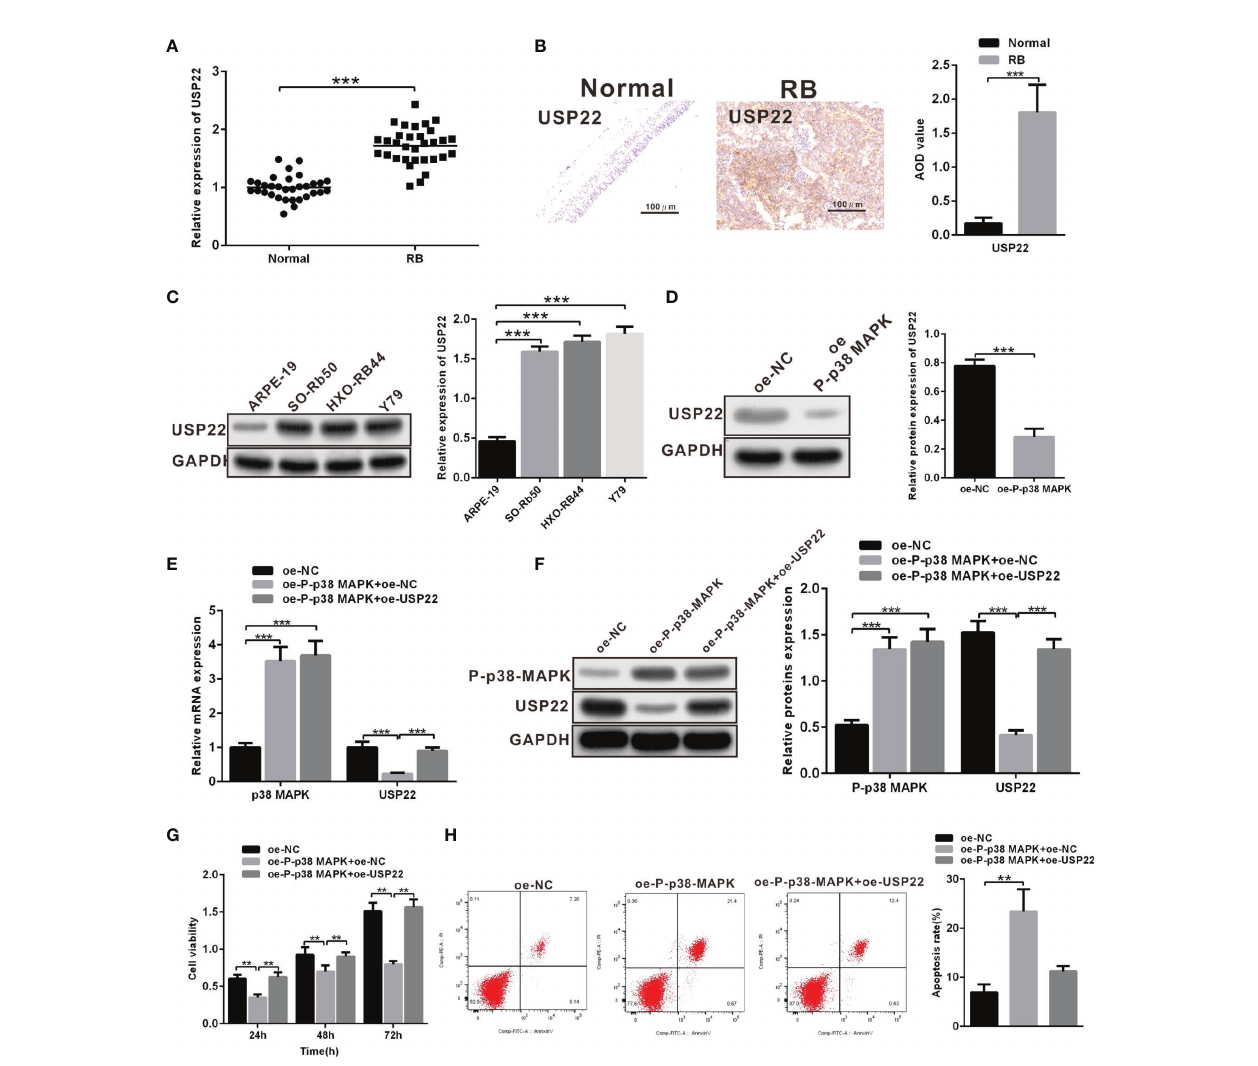
FIGURE 3 | Overexpression of USP22 reverses the inhibitory roles of P-p38 MAPK on RB cell functions. (A) USP22 expression in clinical samples was detected using RT-qPCR (n = 32). (B) USP22 expression in clinical samples was detected using IHC assay. (C) USP22 expression in RB cell lines was measured using western blot analysis. (D) USP22 expression in Y79 cells that over expressed P-p38 MAPK was detected by western blot analysis. (E, F) The expression of P-p38 MAPK and USP22 after overexpression of P-p38 MAPK and USP22 was respectively determined by the means of RT-qPCR and western blot analysis. (G) Cell viability was detected using CCK-8. (H) Cell apoptosis was measured using fl ow cytometry. ** p < 0.01, *** p < 0.001. The measurement data was expressed by mean ± standard deviation. The two groups of data conforming to the normal distribution were compared using unpaired t